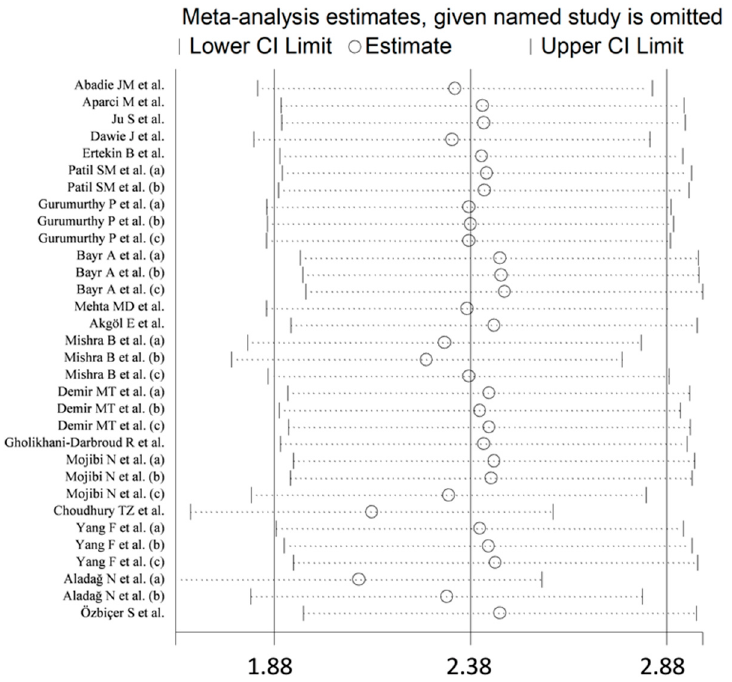
Figure 3. Sensitivity analysis of the association between ischaemia-modified albumin and acute coronary syndrome. For each study, the effect size (hollow circles) corresponds to an overall effect derived from a meta-analysis excluding that study.